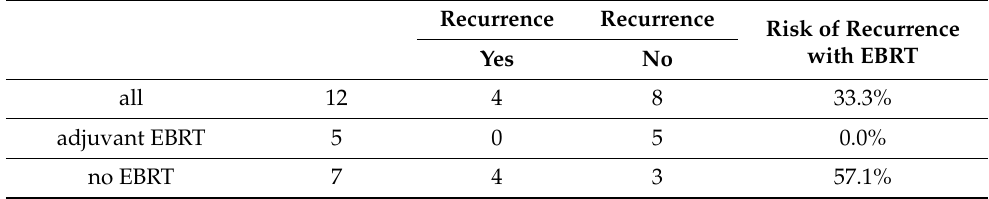
Table 5. Adjuvant EBRT reduces local recurrence risk in patients at high risk of locoregional recurrence (defined as R1 margin status after initial surgery or status post redo